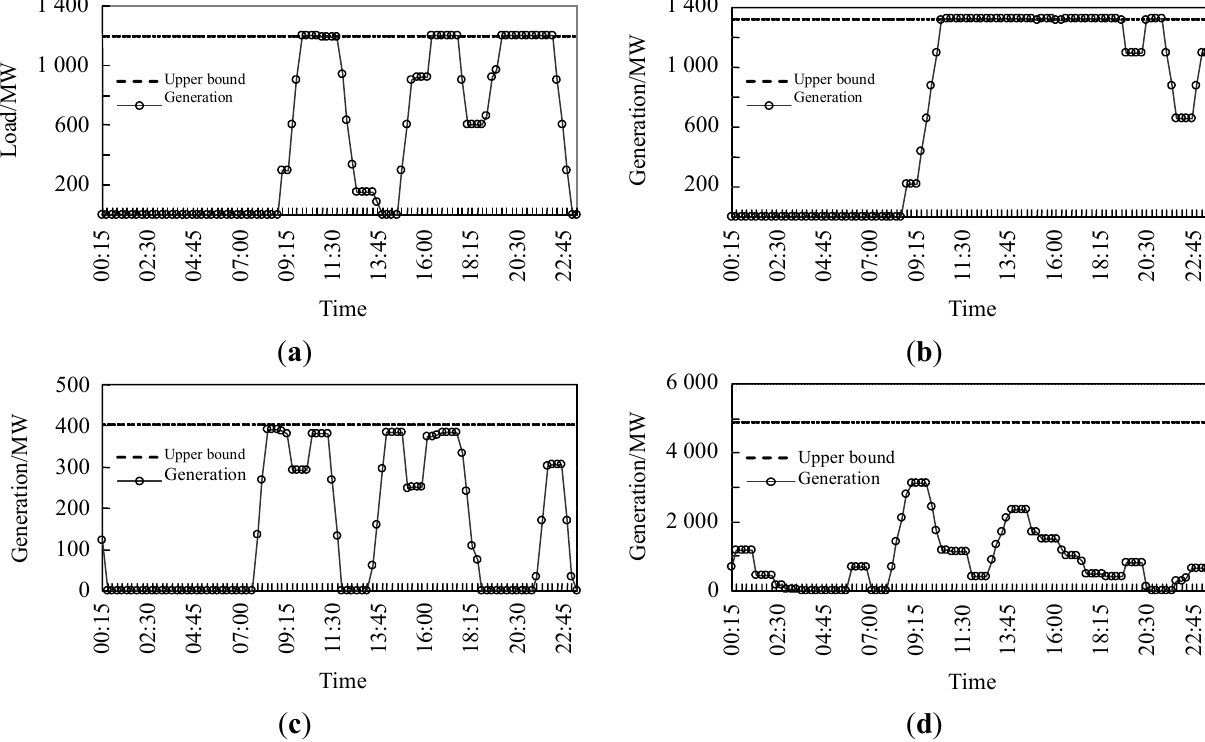
Figure 11. Generation profiles of each hydropower plant: ( a ) Tianshengqiao-1 Plant; ( b ) Tianshengqiao-2 Plant; ( c ) Pingban Plant; and ( d ) Longtan